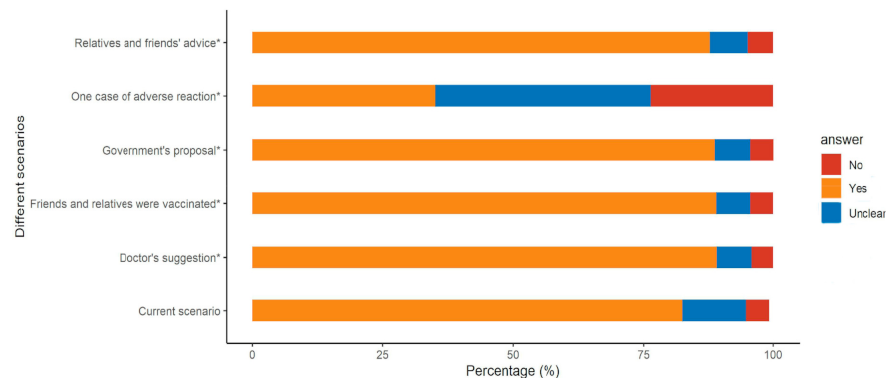
Figure 4. Acceptance under different scenarios. * Had statistical significance (compared with current